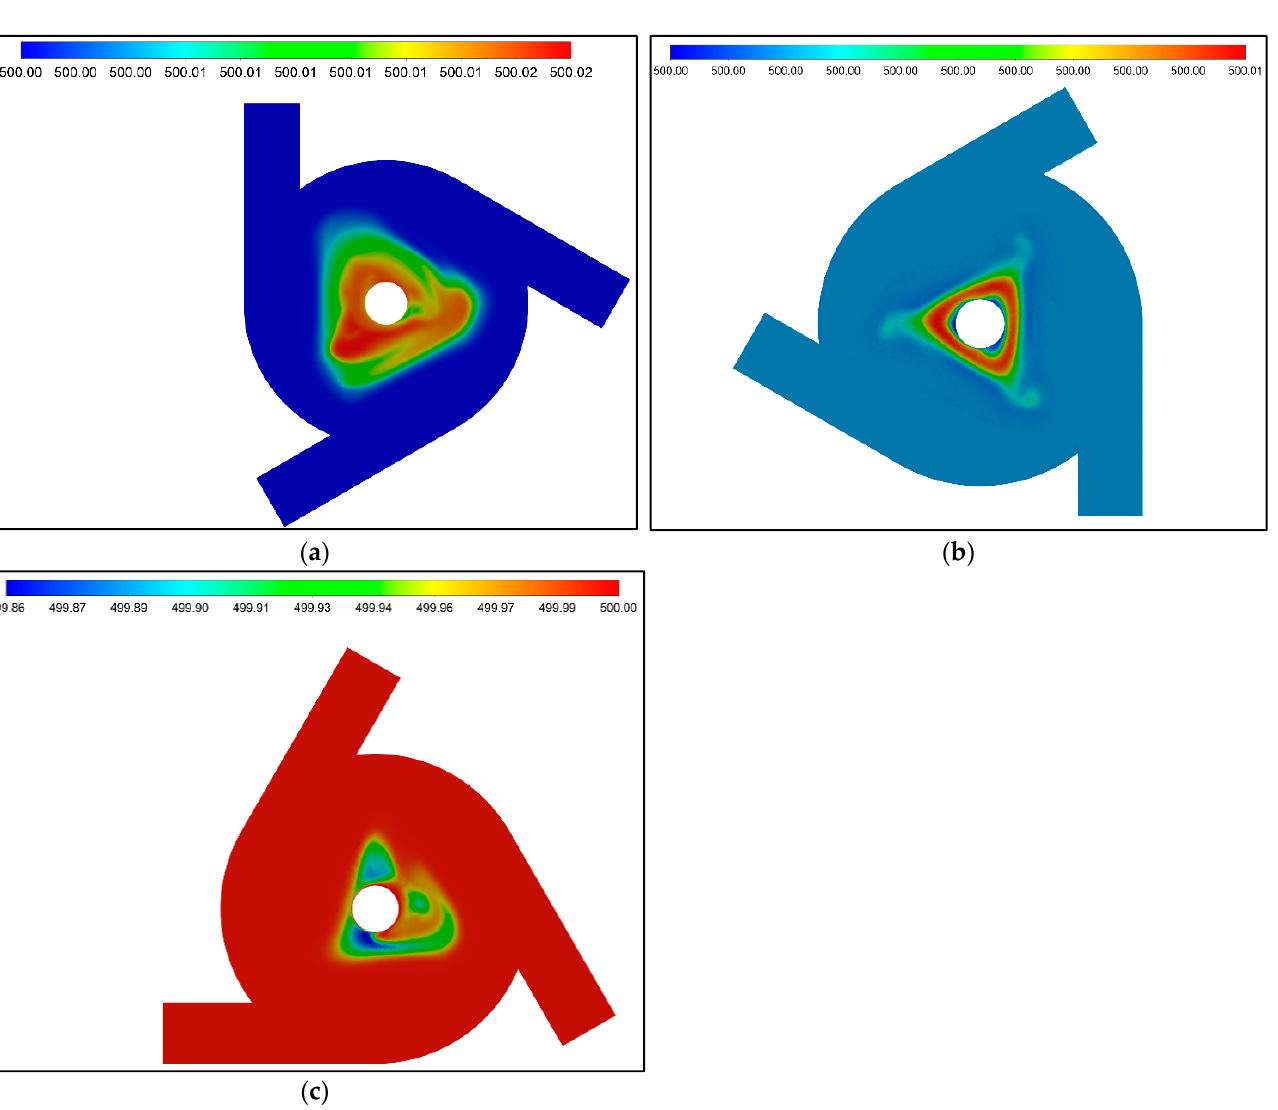
Figure 5. Total temperature contour obtained for SVT with ( a ) inviscid Ar ; ( b ) inviscid CO 2 ; and ( c ) inviscid air.